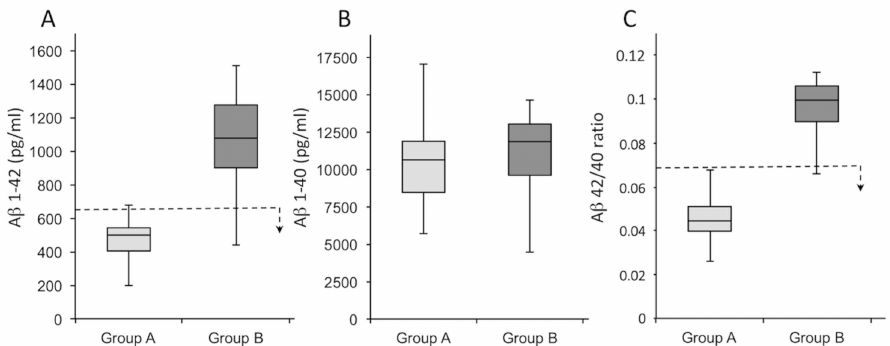
Figure 1. Subdivision of patients into two groups regarding the expression of A β 1–42 ( A ) and A β 1–40 ( B ), and the A β 42/40 ratio ( C ). The dotted line represents the threshold for a subject to be considered AD or non-AD; the arrow indicates the direction of values for which the subjects are affected by AD. Group A is depicted in light gray, and Group B is depicted in dark gray.